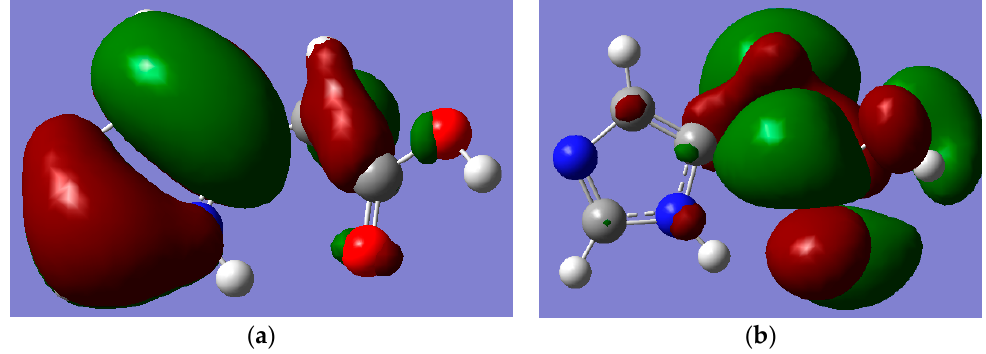
Figure 5. MOs of Hydrogen Bonded Imidazole-4-acetic acid (I) which were calculated by using B3LYP/6-311++G** level of theory. ( a ) HOMO; ( b ) LUMO. Note: carbon, oxygen, nitrogen and hydrogen atoms are in grey, red, blue and white colours, respectively.